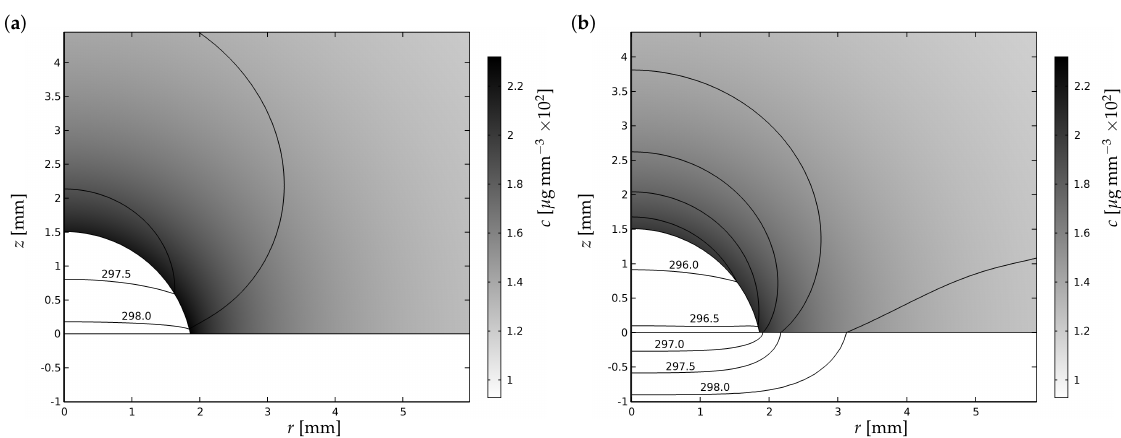
Figure 1. Vapour concentration for a droplet of water with contact angle θ = 1.361 radians and contact radius R = 1.86 mm evaporating into air with T ∞ = 298.15 K on ( a ) a perfectly conducting substrate ( k s = ∞ ) and ( b ) a PTFE substrate ( k s = 0.25 Wm − 1 K − 1 ). Shown also are temperature contours of T , T s and T a in